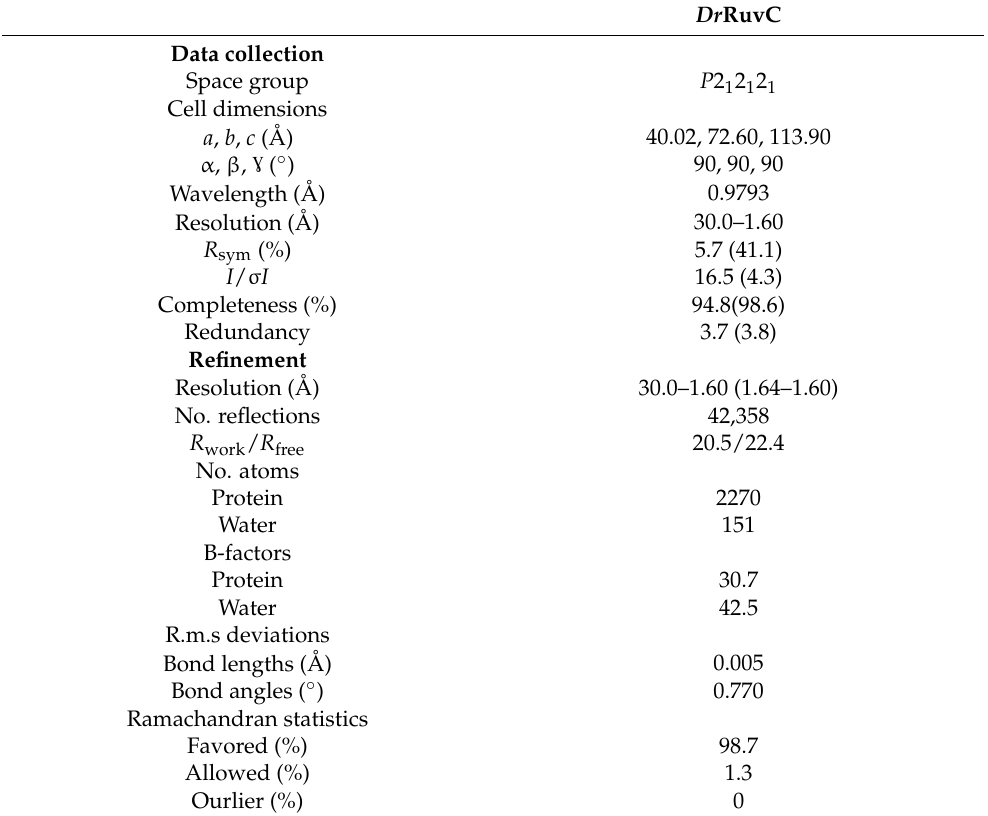
Table 1. Data collection, phasing and refinement statistics.